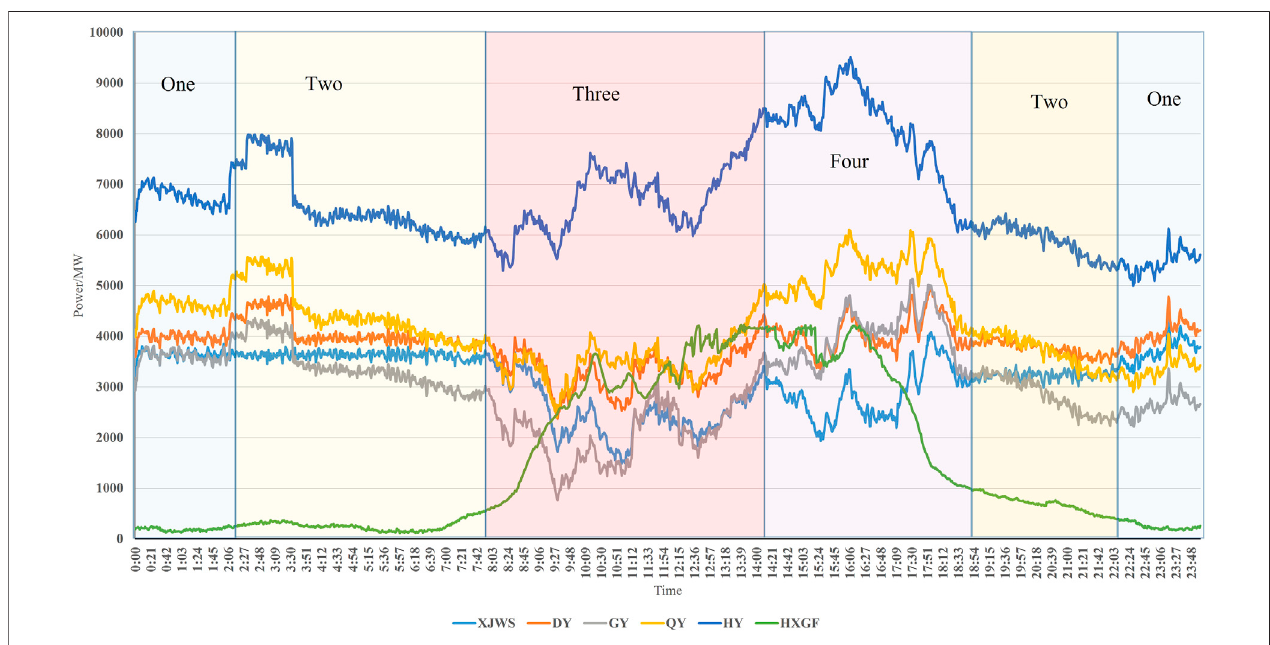
FIGURE 4 | Typical daily clustering results for the test system.